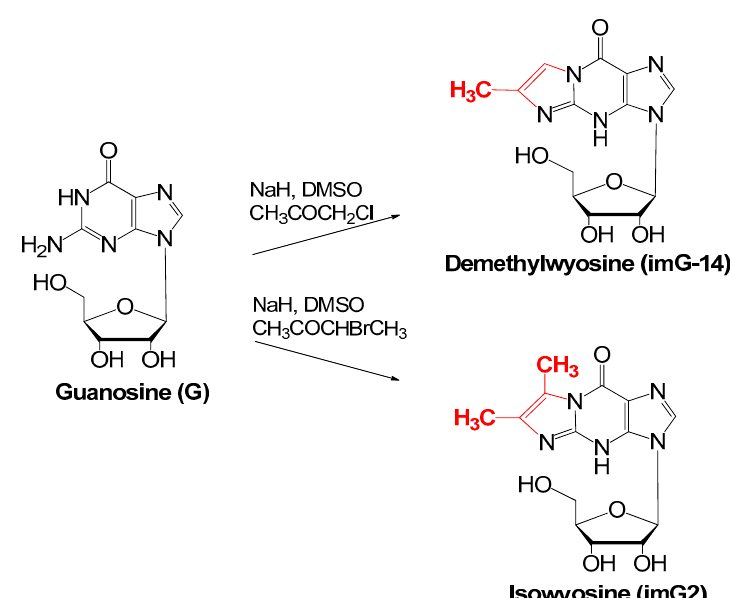
Scheme 3. Formation of tricyclic fluorescent demethylwyosine (imG-14) and isowyosine (imG2) nucleosides by intramolecular cyclization